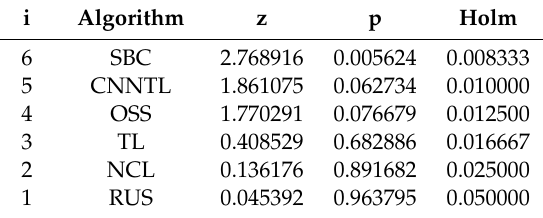
Table 21. Results of the Holm test comparing the performance of the NAC classifier after undersampling algorithms. i Algorithm z p